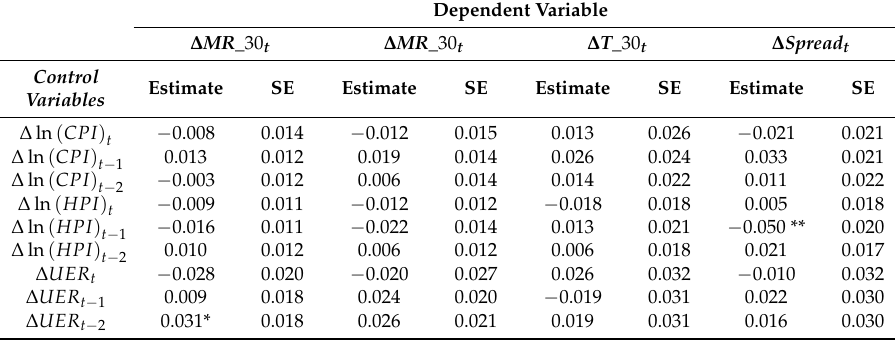
Table A3. Coefficient estimates of additional control variables in regressions. The change of log unexpected CPI, the change of log unexpected Case-Shiller House Price Index (HPI), the change of unexpected unemployment rate (UER), and the lagged variables (2 lags for each of these 3 variables) are added to each of the 4 models as independent variables. This table only reports the estimates and standard errors of coefficients associated with these newly added variables by using the 1-day event window. ARs, CARs and coefficient estimates of other independent variables are not reported in this table since the values and significances of them are similar to the case without including these control variables.